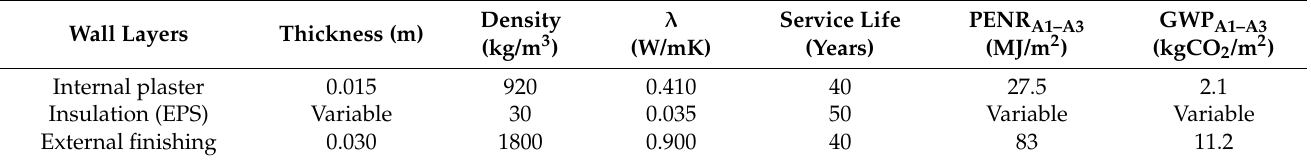
Table 11. Parameters characterizing finishing and insulation